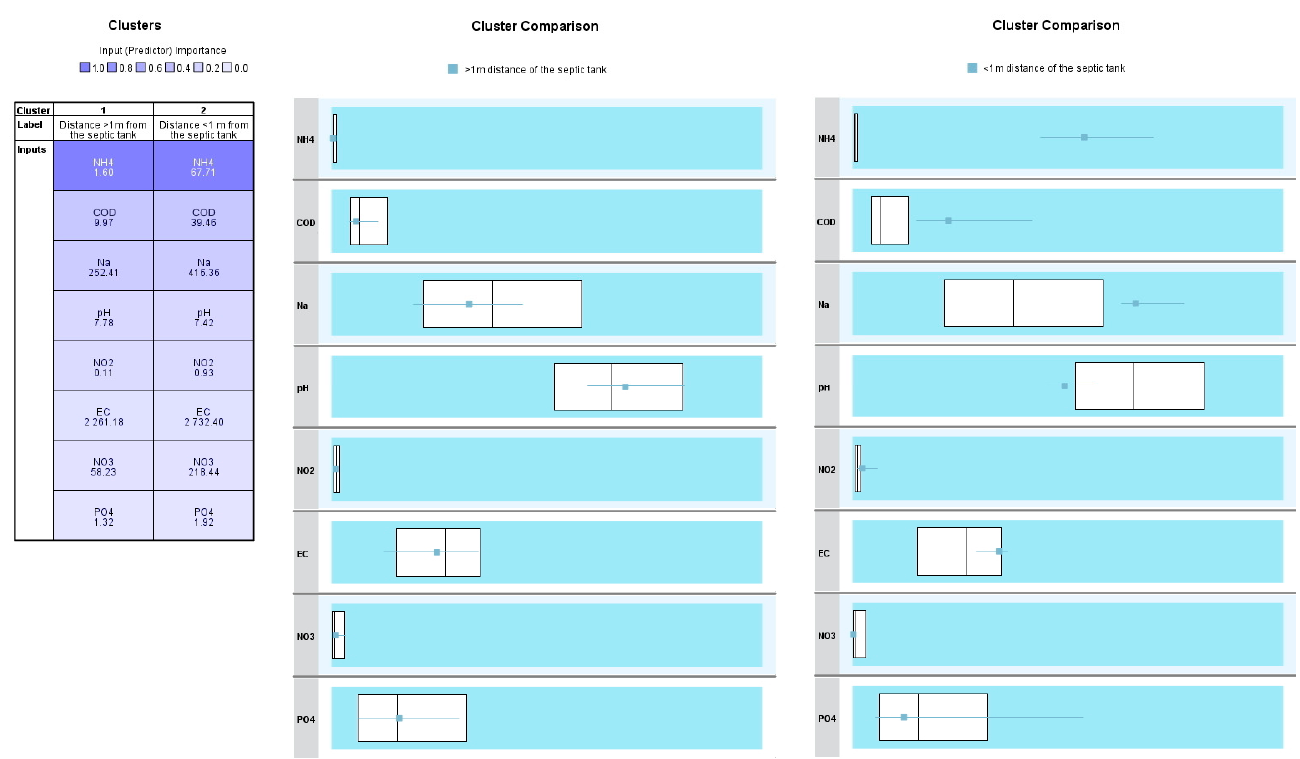
Figure 11. Clusters and cluster comparison for data before the elimination of the septic tank.